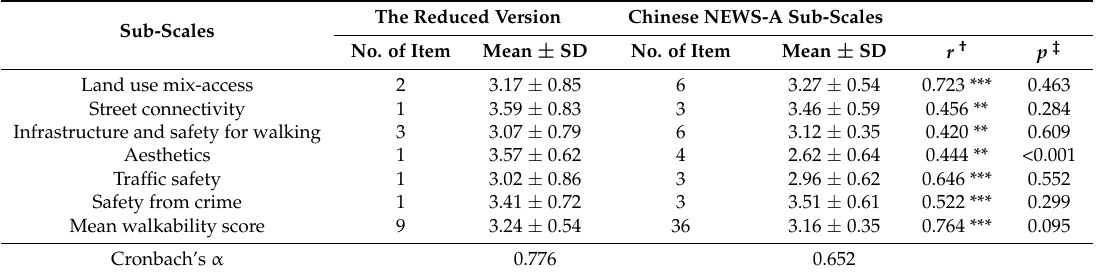
Table A1. Perceived neighborhood walkability: The reduced version vs. Chinese NEWS-A ( n =